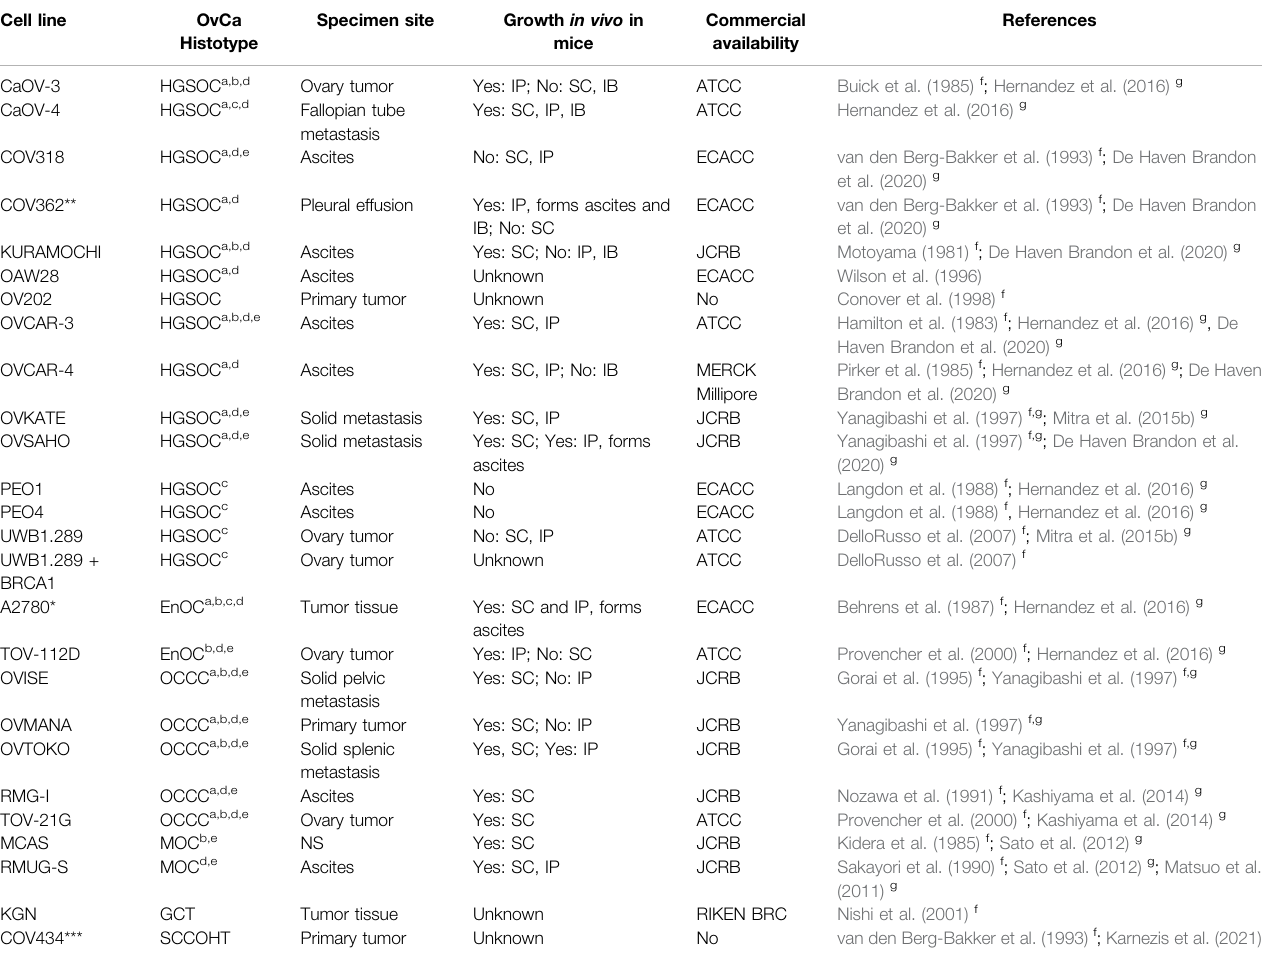
TABLE 1 | Ovarian cancer cell line origin, in vivo growth and classi fi cations. Cell